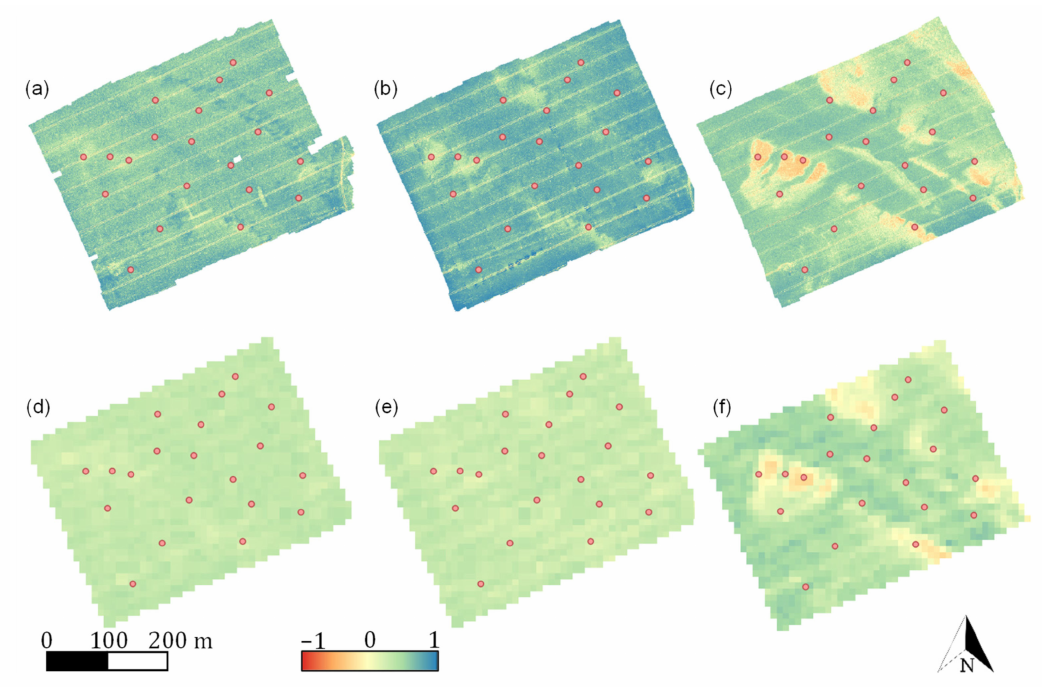
Figure 6. Modified green red vegetation index (MGRVI) of the study area A for wheat. UAV imagery was acquired on ( a ) 16 April 2019, ( b ) 13 May 2019, and ( c ) 11 June 2019. Sentinel-2 imagery was acquired on ( d ) 9 April 2019, ( e ) 12 May 2019, and ( f ) 13 June 2019. The points indicate the locations for reference sampling.